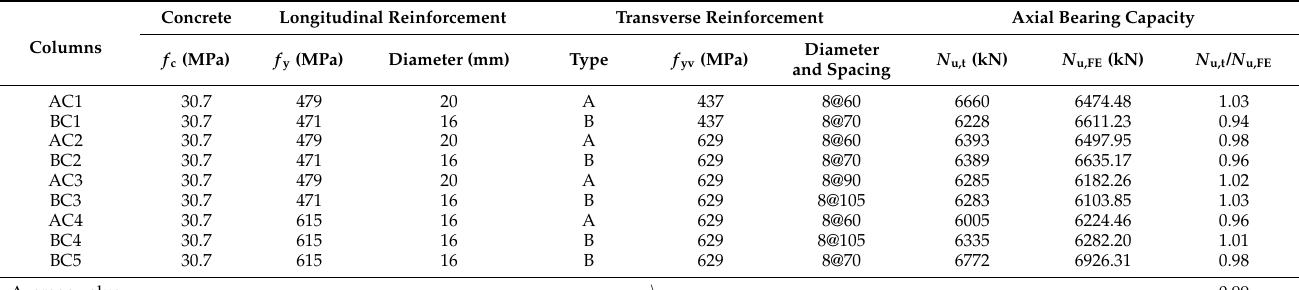
Table 2. Specimen parameters and finite element analysis